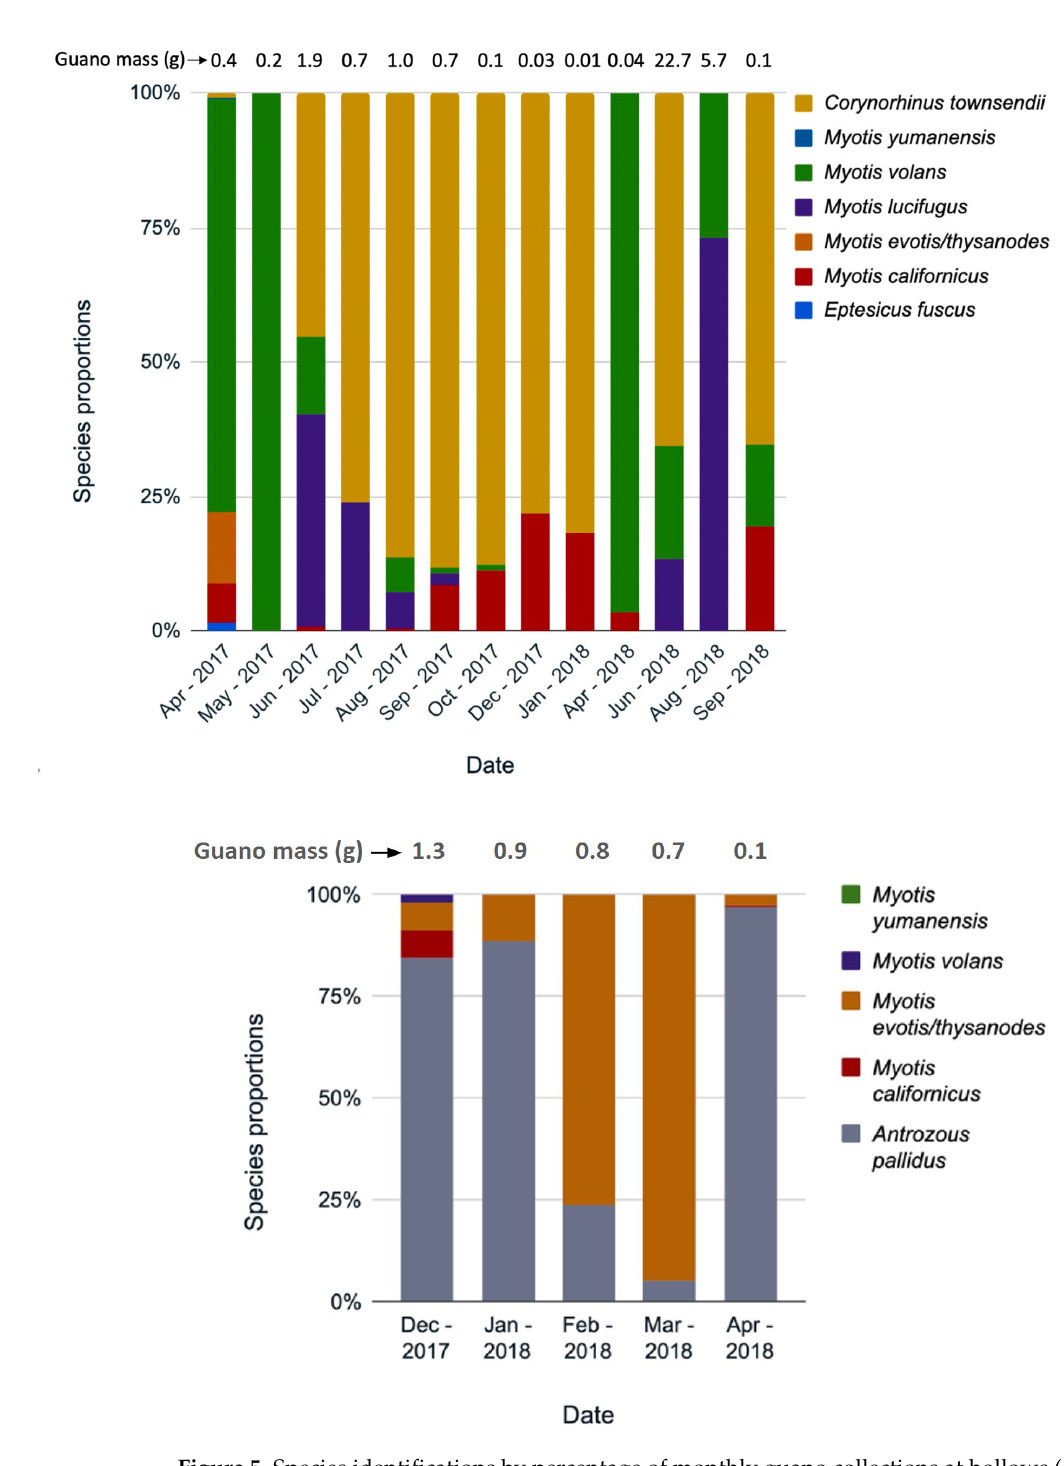
Table 3. Generalized Additive Mixed Model (Program R, “mgcv” package) rankings based on